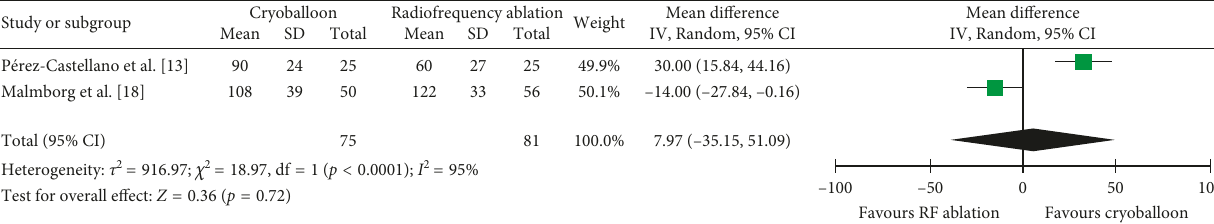
Study or subgroup